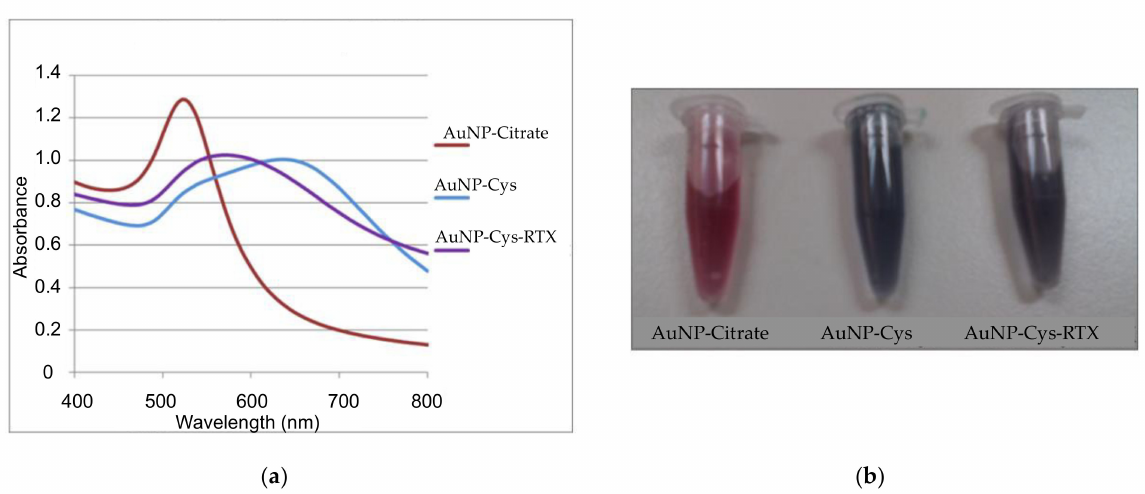
Figure 1. ( a ) UV–vis spectra of AuNP-citrate, AuNP-Cys, and AuNP-Cys-RTX. ( b ) shows the change in the color of AuNP-citrate after the addition of cysteine and Raltitrexed